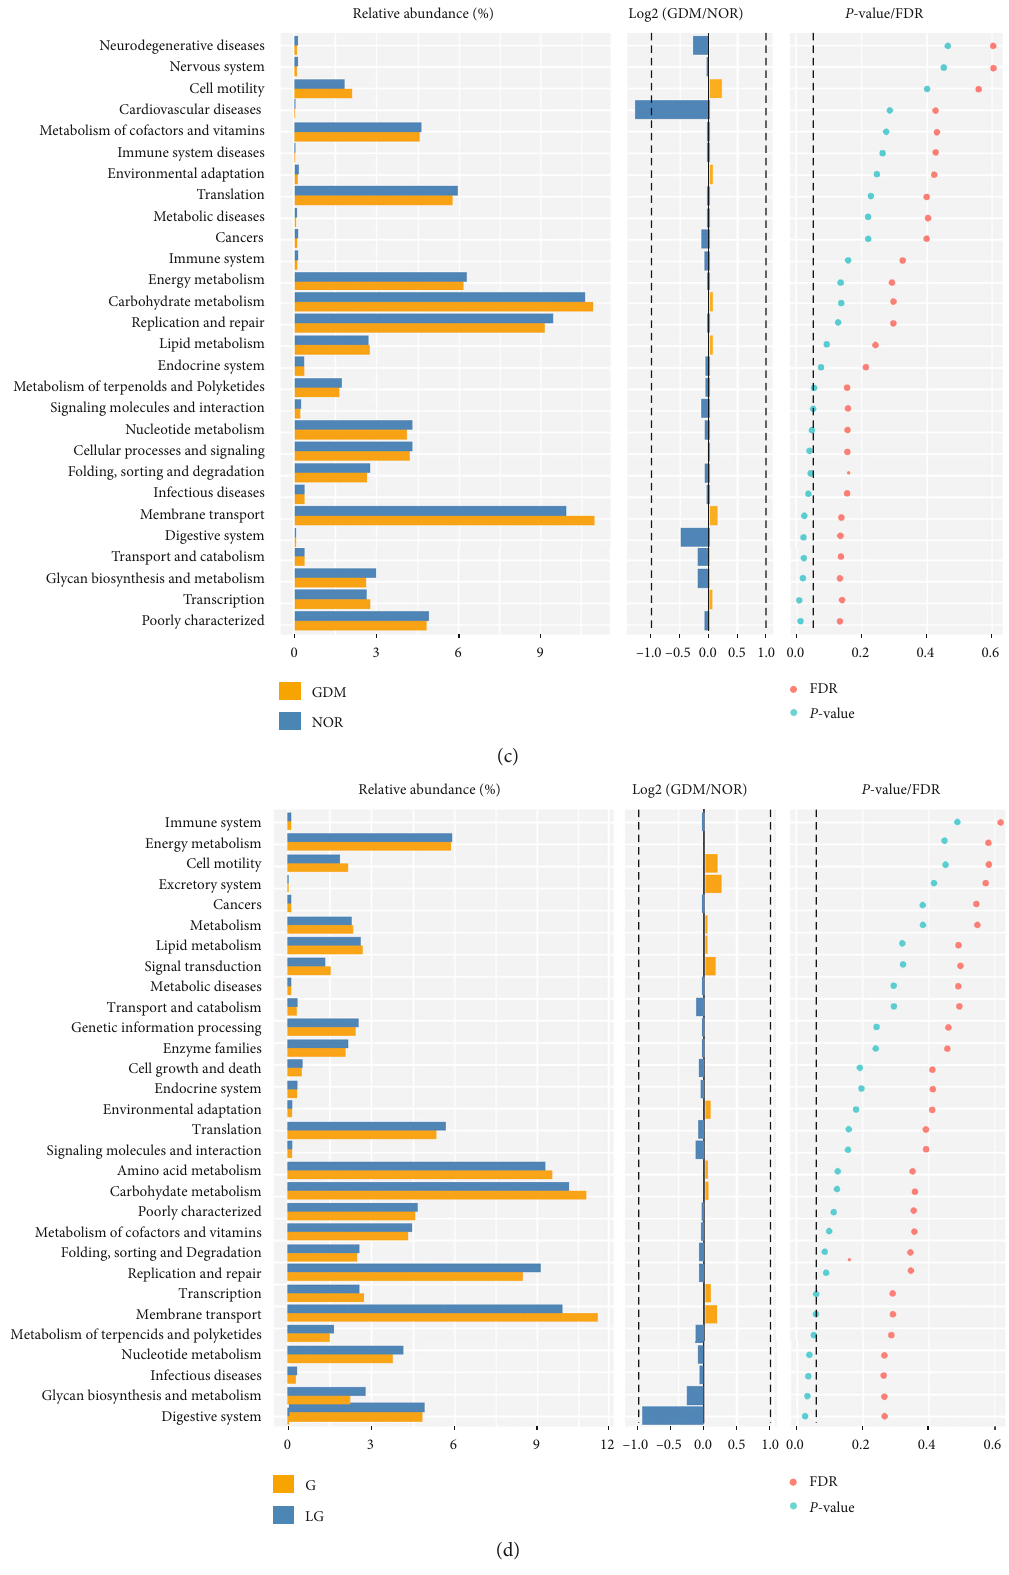
Figure 6: Analysis of the di ff erence in intestinal microbial function between di ff erent groups. (a, b) Comparative analysis of COG level 2 di ff erence between the NOR and GDM groups and the G and LG groups; (c, d) comparative analysis of KEGG level 2 di ff erence between the NOR and GDM groups and the G and LG